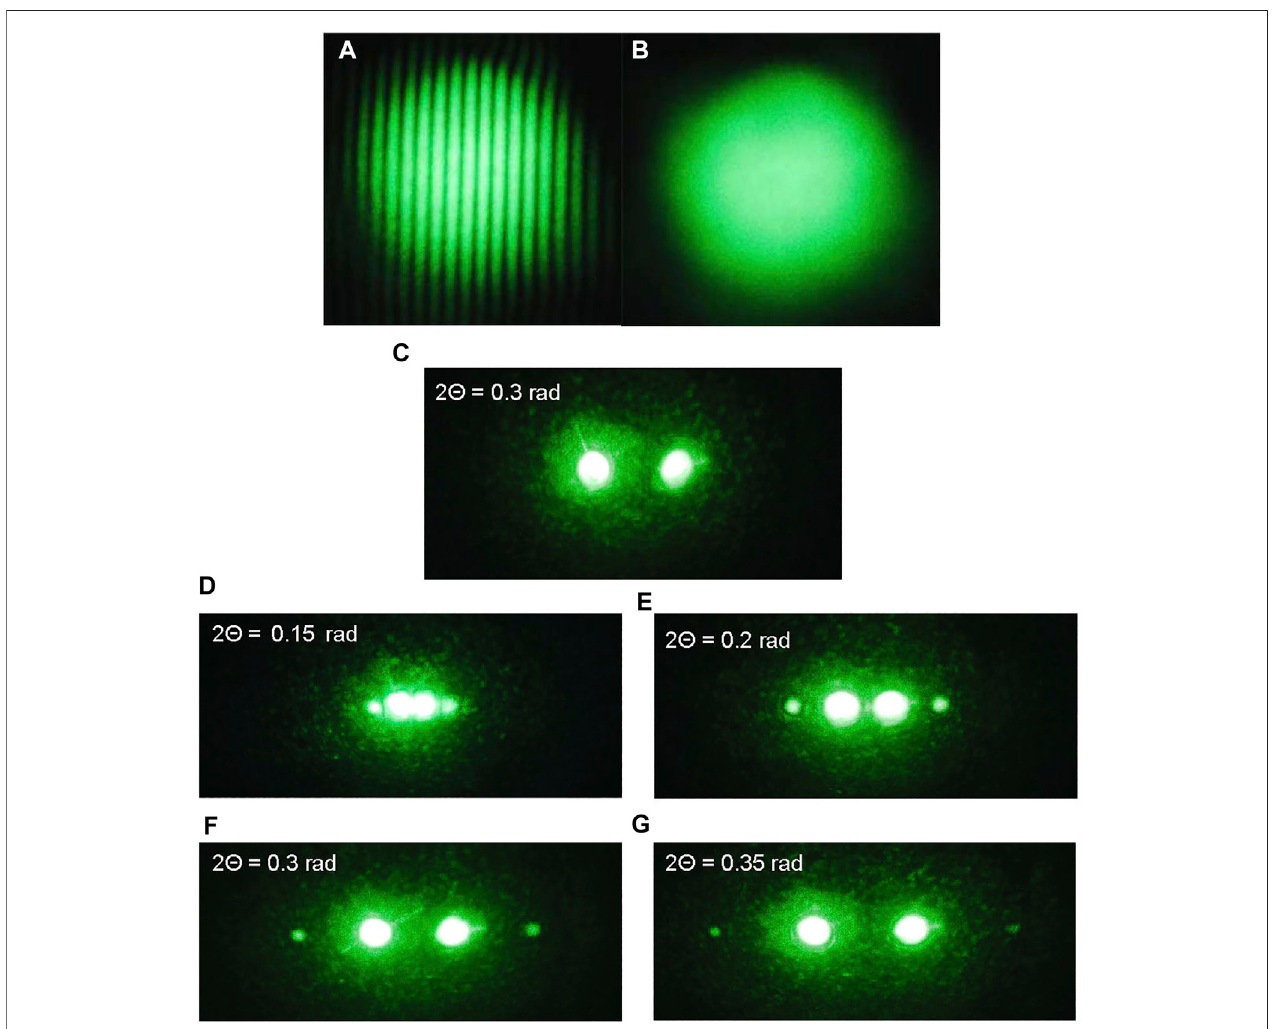
FIGURE 8 | The fi eld pattern observed inside the cuvette: (A) when both beams are coherent and (B) when the beams are incoherent. Registered light intensity distributions in the screen plane ( Figure 7 ): (C) the plane-parallelplateis placed instead of the sample, the self-diffraction isabsent; (D – G) the self-diffraction patterns at different angles of the beams ’